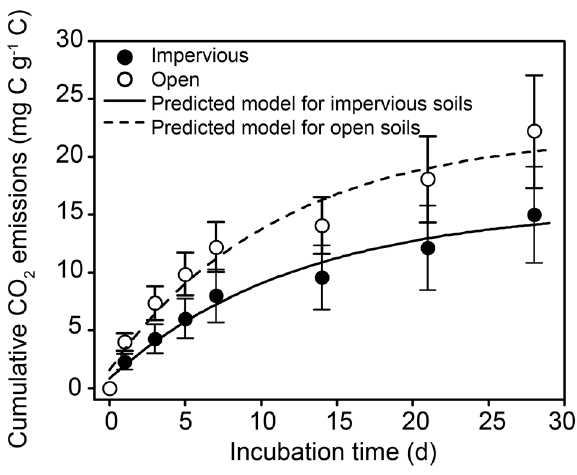
Figure 4. Cumulative carbon release (as CO 2 ) from the impervious-covered and open soils during the 28-d incuba- tion. Data were fitted by the first-order decay model. The bars indicate standard errors ( n =7 for urban impervious-covered soils, and n =6 for